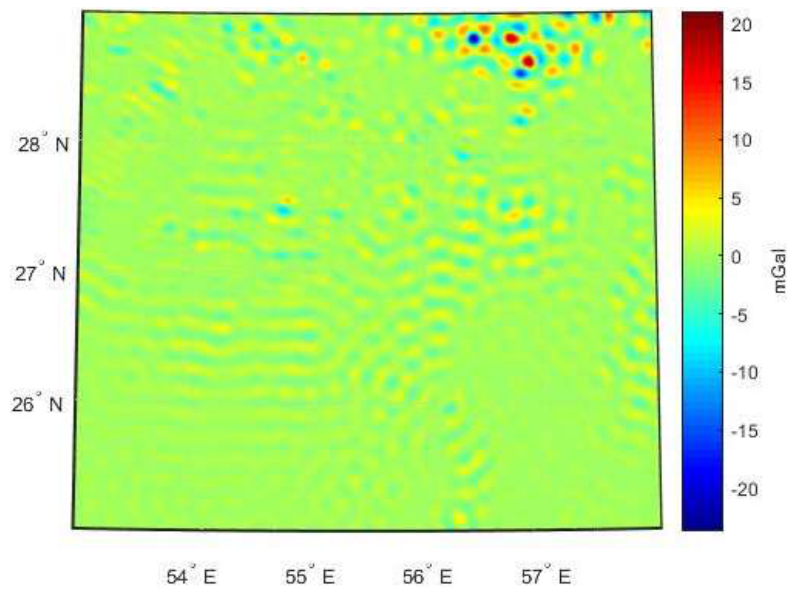
Figure 7. The discrepancies between predicted and observed gravity anomalies (mGal).